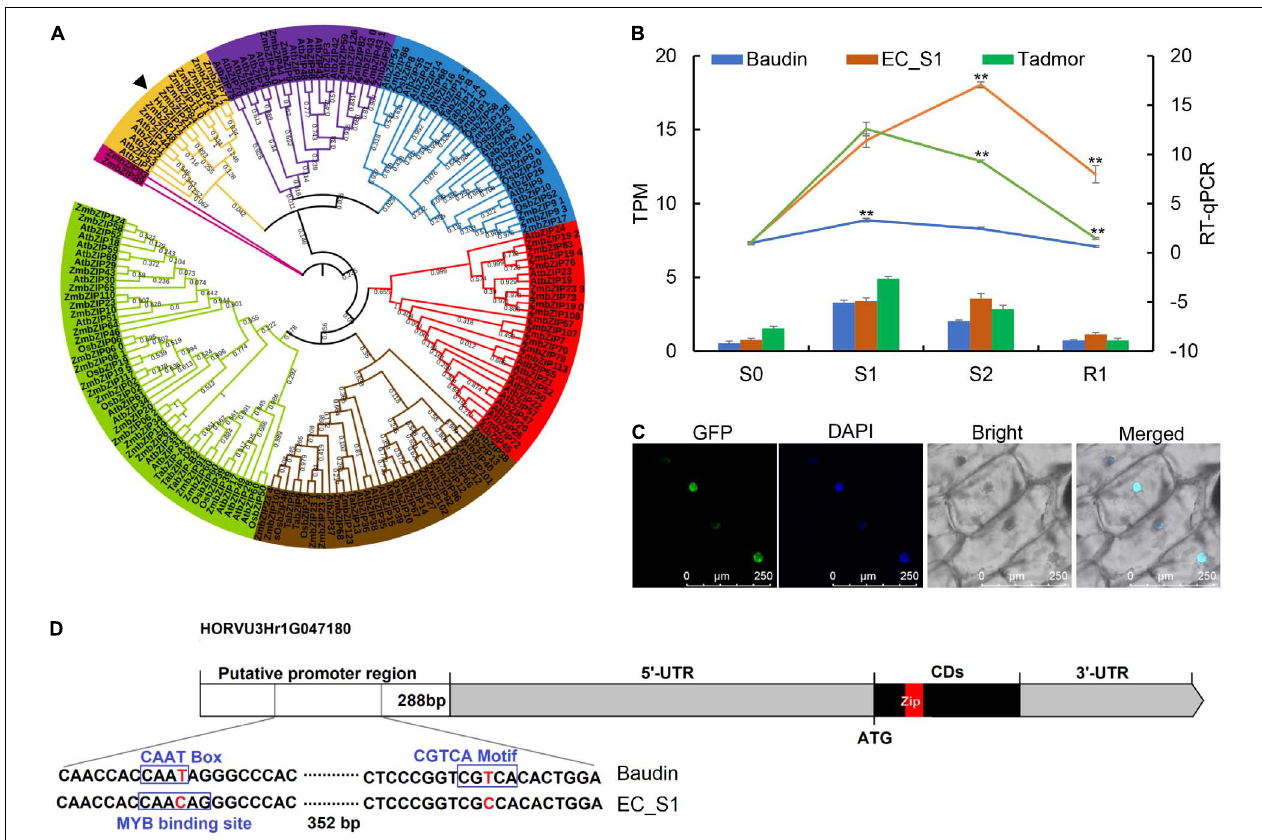
FIGURE 6 | The evolution, expression pattern, subcellular localization and gene structure of HvbZIP21 . (A) Phylogenetic tree constructed by the neighbor-joining algorithm with a bootstrap value of 1,500; (B) the expression level of HvbZIP21 from transcriptome data (TPM) and RT-qPCR; * and ** indicate significance levels at P ≤ 0.05 and 0.01, respectively ( n = 3 independent replicates). (C) the subcellular localization of HvbZIP21 ; (D) the structure of HvbZIP21 in